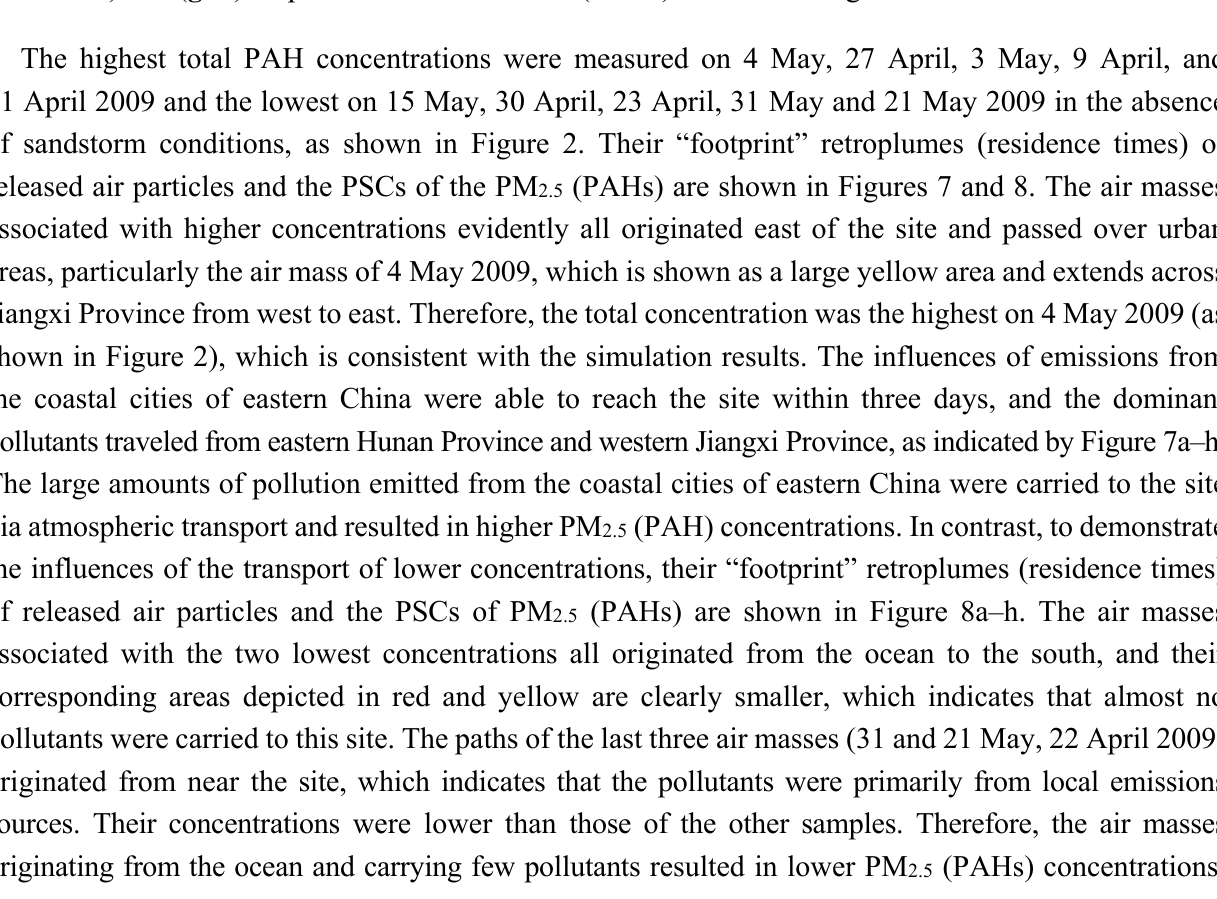
Figure 8. Illustrations of three-day backward retroplumes and potential source contributions (PSCs) of lower PAH levels. ( a – f ) Map of the “footprint” ( i.e. , 100 m) retroplume (residence time) and ( g – h ) maps of the PSCs of PM 2.5 (PAHs) at Mount